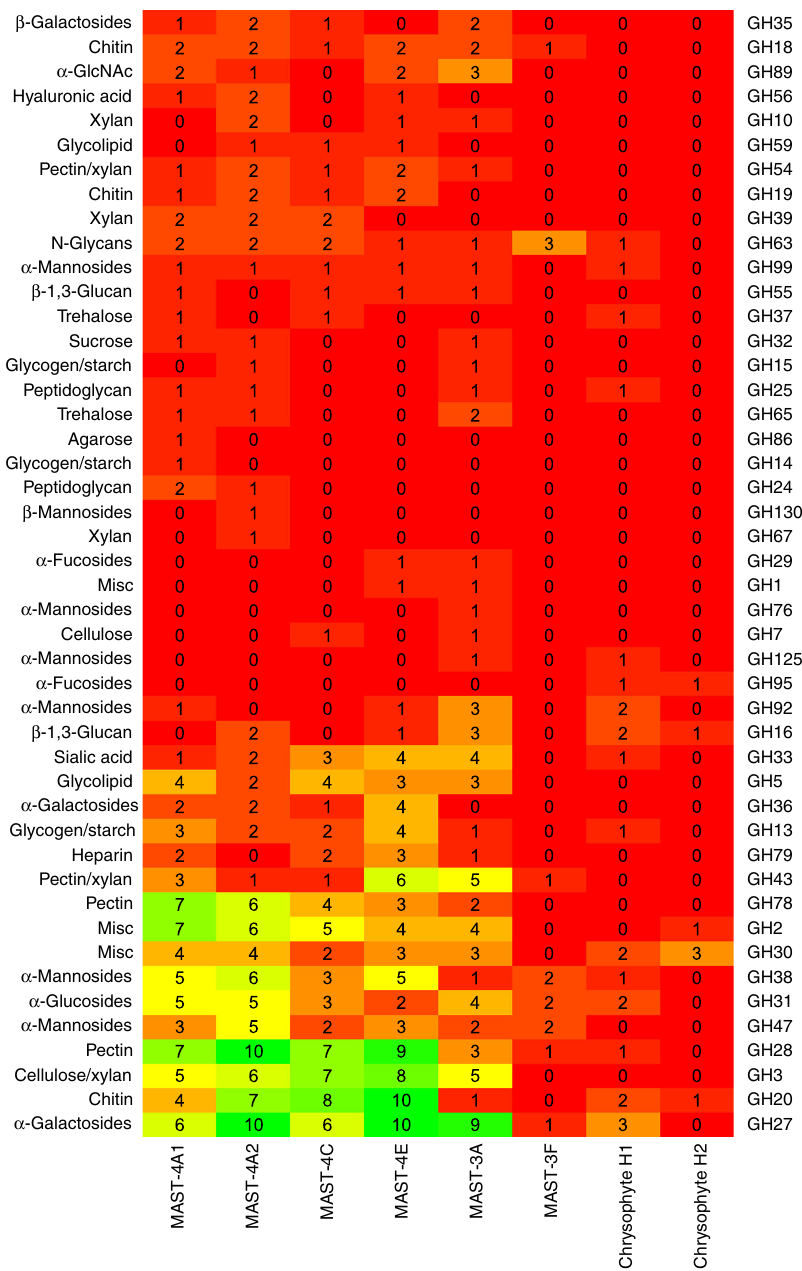
Fig. 2 SAG lineage glycoside hydrolases (GHs). GH families are numbered (right) according to the CAZyme database. Potential substrates are indicated on the left side. Internal numbers represent the number of genes in each genome predicted to belong to the GH category. Colors indicate the number of predicted GH genes per family, from low (red) to high